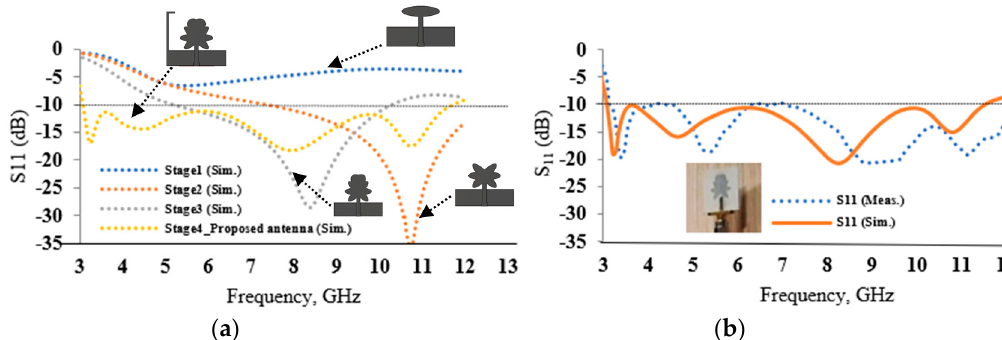
Figure 3. Surface current distribution at different stages of the proposed UWB antenna: ( a ) 5.2 GHz ( b ) 10.7 GHz ( c ) 8.2 GHz, and ( d ) 8 GHz. Figure 4. ( a ) simulated S 11 characteristics during evolution stages ( b ) simulated and measured S 11 characteristics of the proposed antenna element.